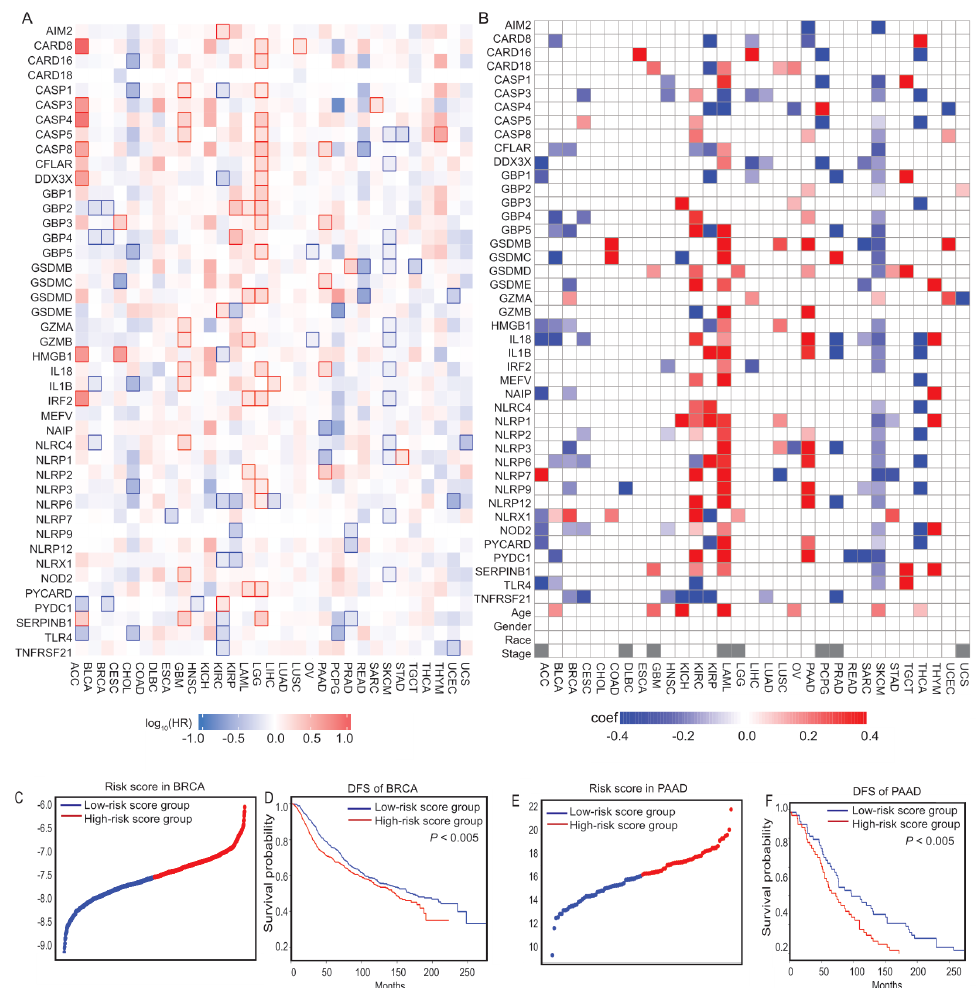
Figure 4. The prognostic values of PRGs. ( A ) The survival contribution between 43 PRGs and DFS. The heat map shows the hazard ratios on a logarithmic scale (log10) for different genes. The red and blue blocks denote higher and lower risks, respectively. The rectangles with frames indicate significantly unfavorable and favorable results in prognostic analyses. ( B ) Risk model across 31 cancer types. Because of the limited sample size for clinical cancer stage information, 8 types of cancer were excluded from the analysis (marked as gray box). ( C ) The distribution of the risk scores for BRCA from ICGC data. ( D ) Kaplan-Meier curves for the DFS of patients in the high-risk and low-risk groups for BRCA from ICGC data. ( E ) The distribution of the risk scores for PAAD from ICGC data. ( F ) Kaplan-Meier curves for the DFS of patients in the high-risk and low-risk groups for PAAD from ICGC